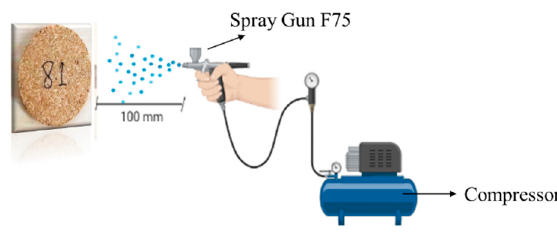
Figure 1. Application of spraying method for coating. Table 1. Sample condition in experimental design.